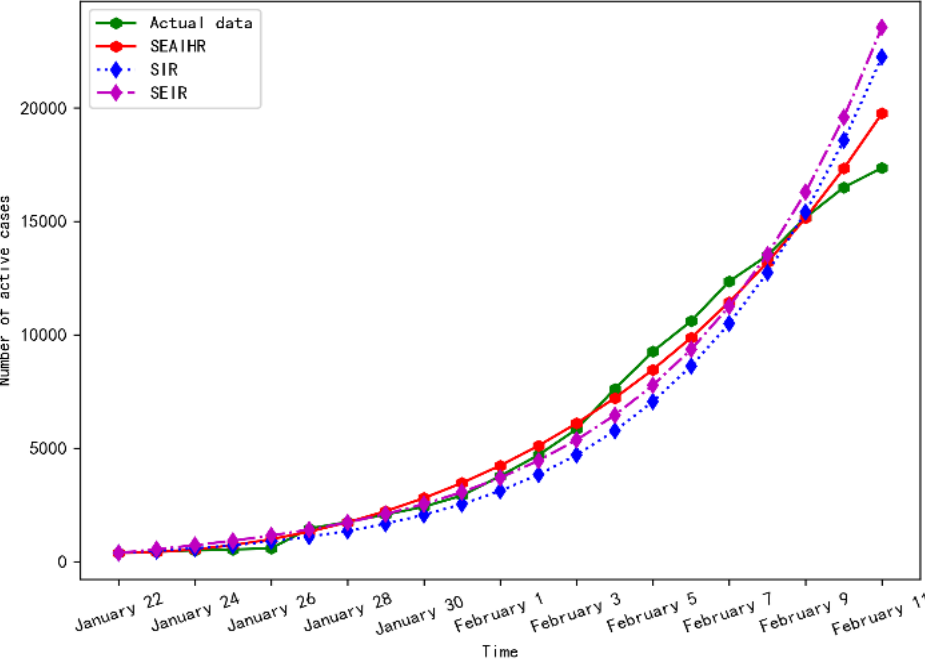
Figure 5. Simulation results comparison of stage 1.